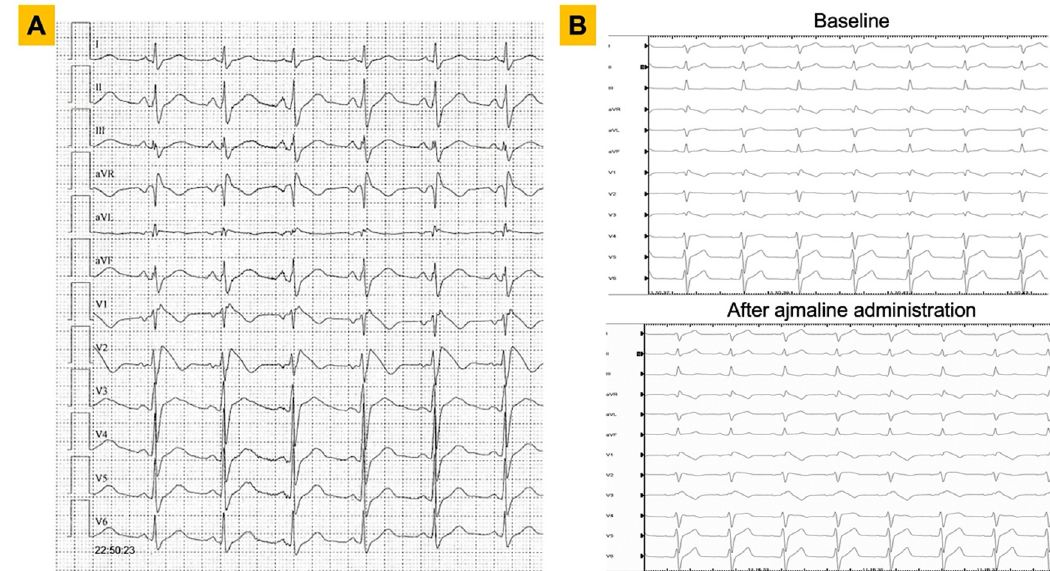
Figure 1. ECG findings in patients with Brugada syndrome. Representative examples of diagnostic ECGs for Brugada syndrome are shown. Panel ( A ). A 25-year-old male with a spontaneous type 1 pattern on 12-lead ECG. Panel ( B ). A 36-year-old male with right bundle branch block pattern on baseline ECG (upper panel) and subsequent unmasking of a type 1 Brugada ECG pattern after administration of ajmaline at 1 mg/kg (lower panel). ECG = electrocardiogram.